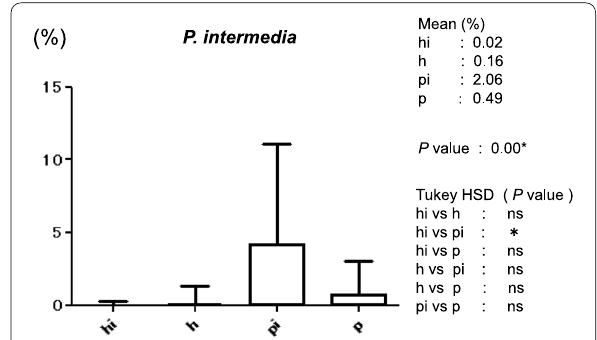
Fig. 8 Average proportion (%) of bacteria to total copy-count for Prevotella